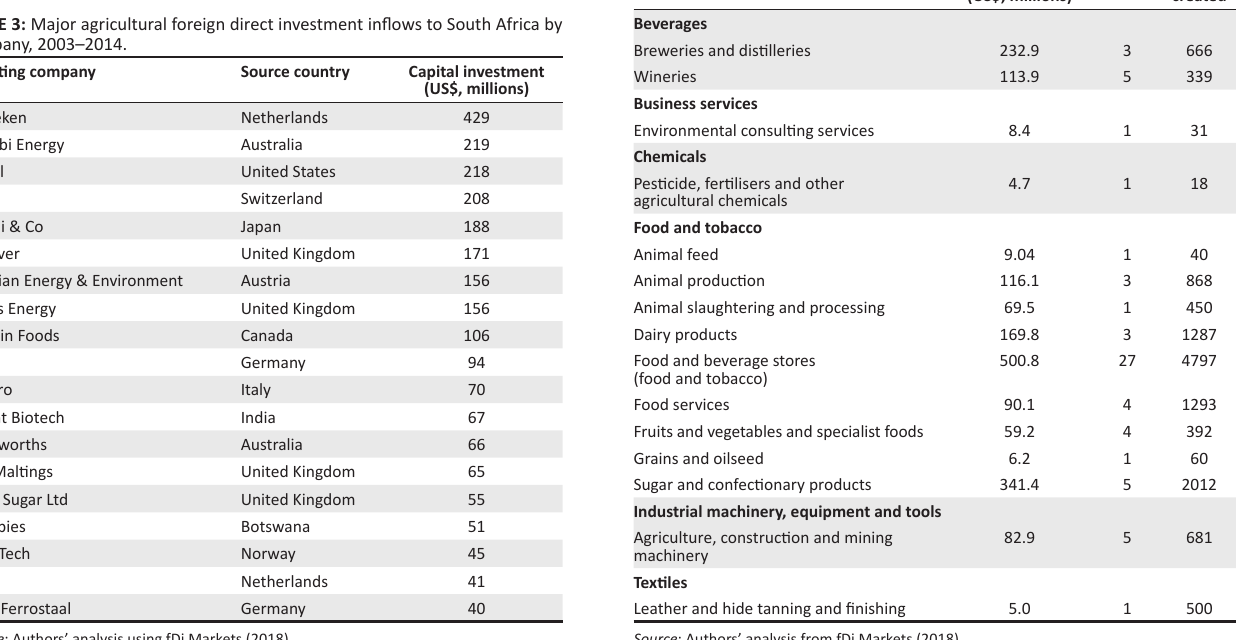
TABLE 4: Agricultural foreign direct investment outflows from South Africa by sector and sub-sector, 2003–2014. Industry/sub-sector